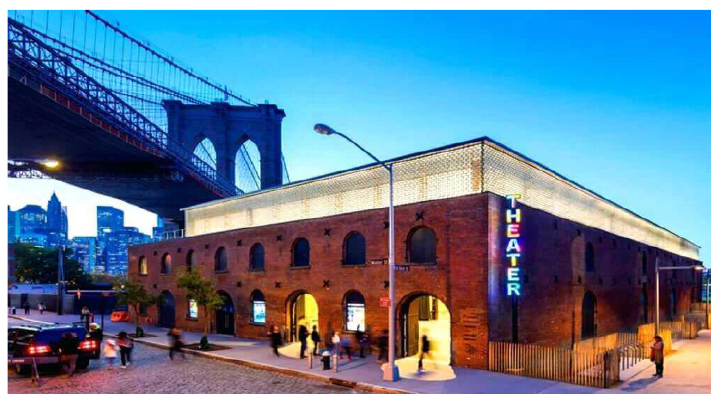
Fig. 6. Tobacco Warehouse plans ( Sarah, 2017) .